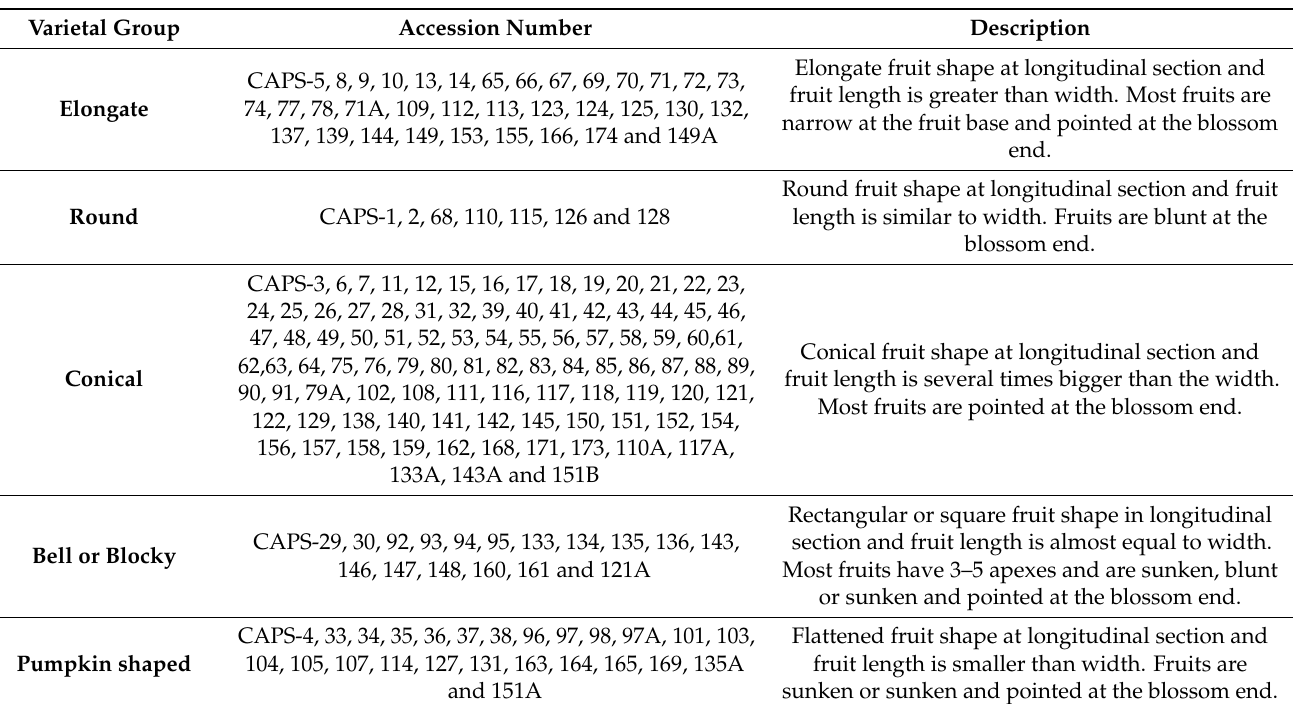
Table 3. Plant materials used from pepper accessions of predefined varietal groups of Elongate, Round, Conical, Bell or Blocky, and Pumpkin fruit shape. The “A” and “B” letters assigned to given accessions indicate that the selected accession differs from original population based on differences in phenotypic traits (fruit shape, colour, and taste, among others) and since then accessions have been characterised